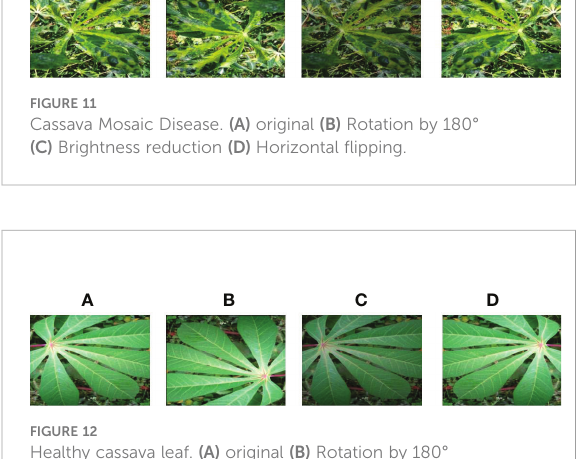
FIGURE 12 Healthy cassava leaf. (A) original (B) Rotation by 180° (C) Brightness reduction (D) Horizontal fl